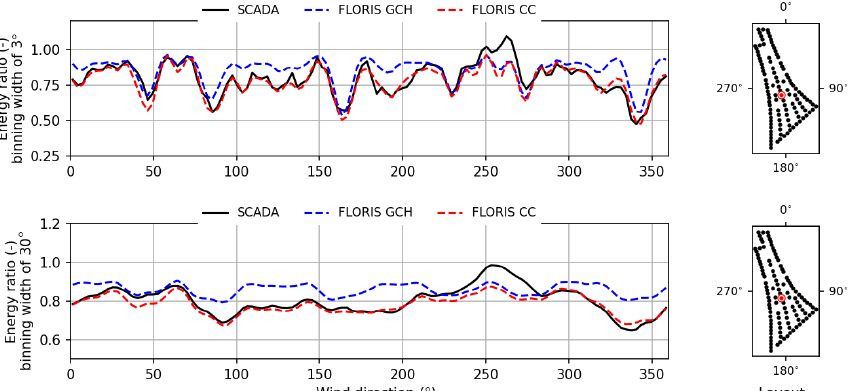
Figure 14. Energy ratio versus wind direction for Turbine 51, located in the center of the Anholt wind farm. The reference turbines to which the energy ratio is normalized are the five closest wind turbines that are operating in freestream flow. The reference wind direction is determined by the nacelle headings from turbines directly neighboring Turbine